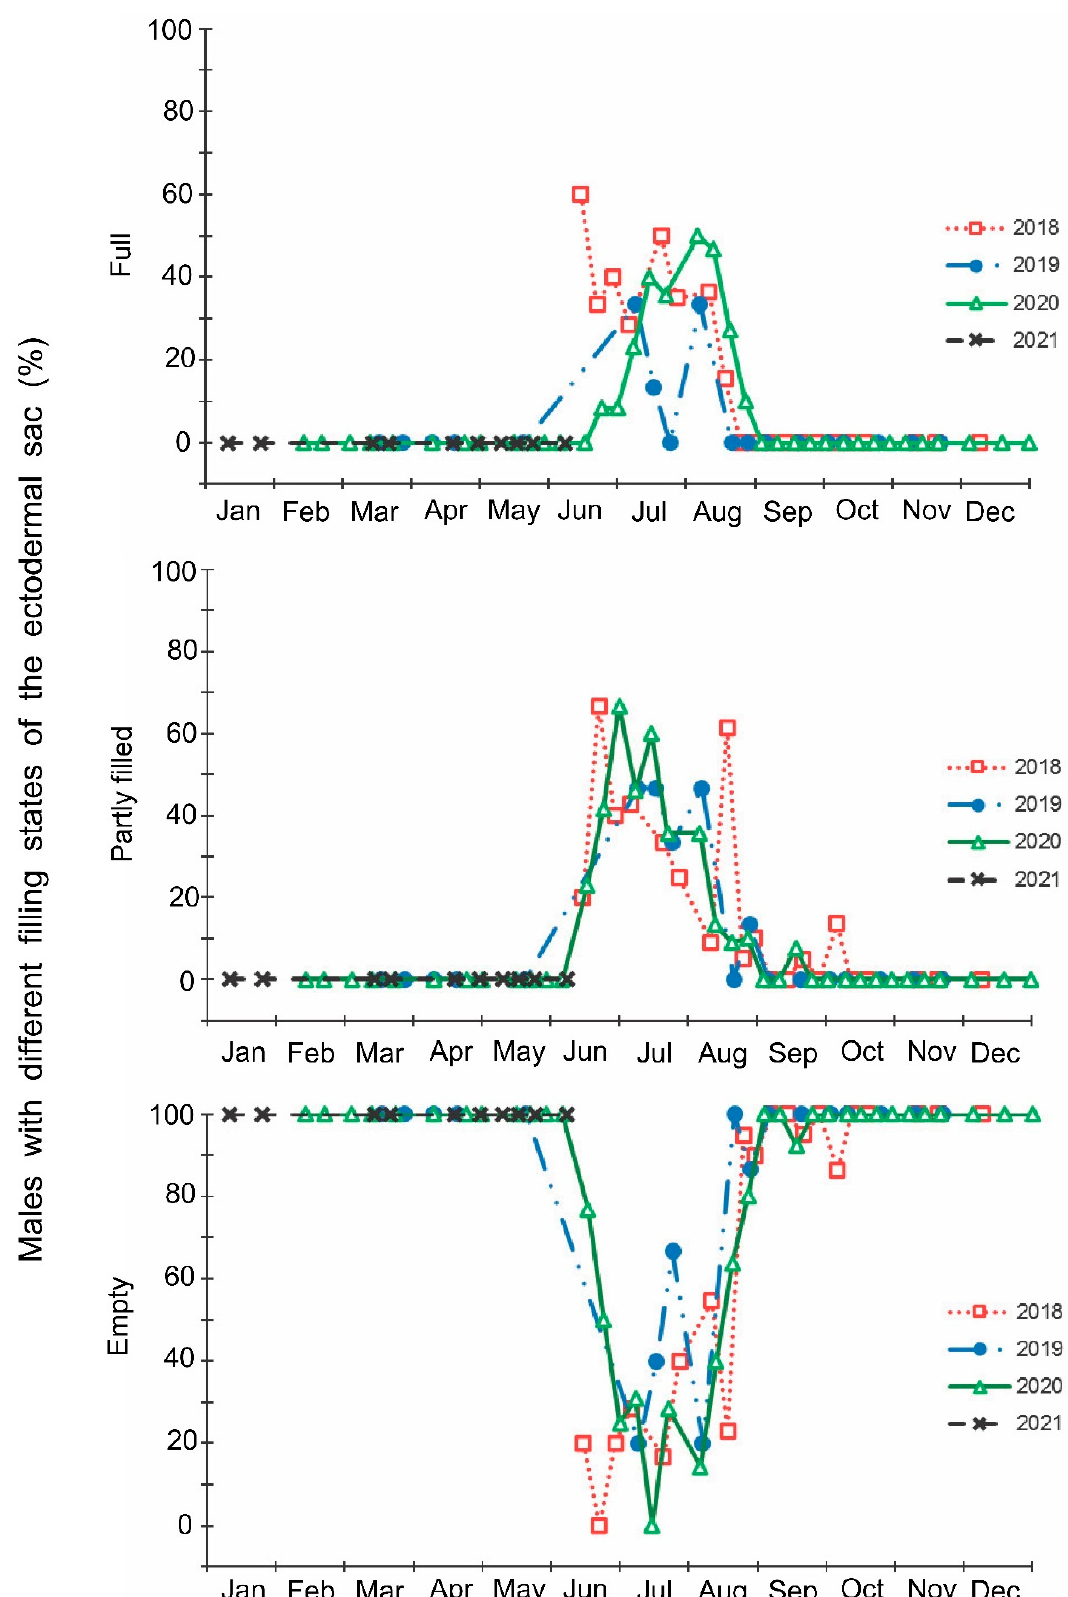
Figure 5. Seasonal changes in the proportions of Halyomorpha halys males with different states of the ectodermal sac during 2018–2021. Each symbol corresponds to one sample of field-collected males (3–29 males per sample with a total of 1154 males in 85 samples).